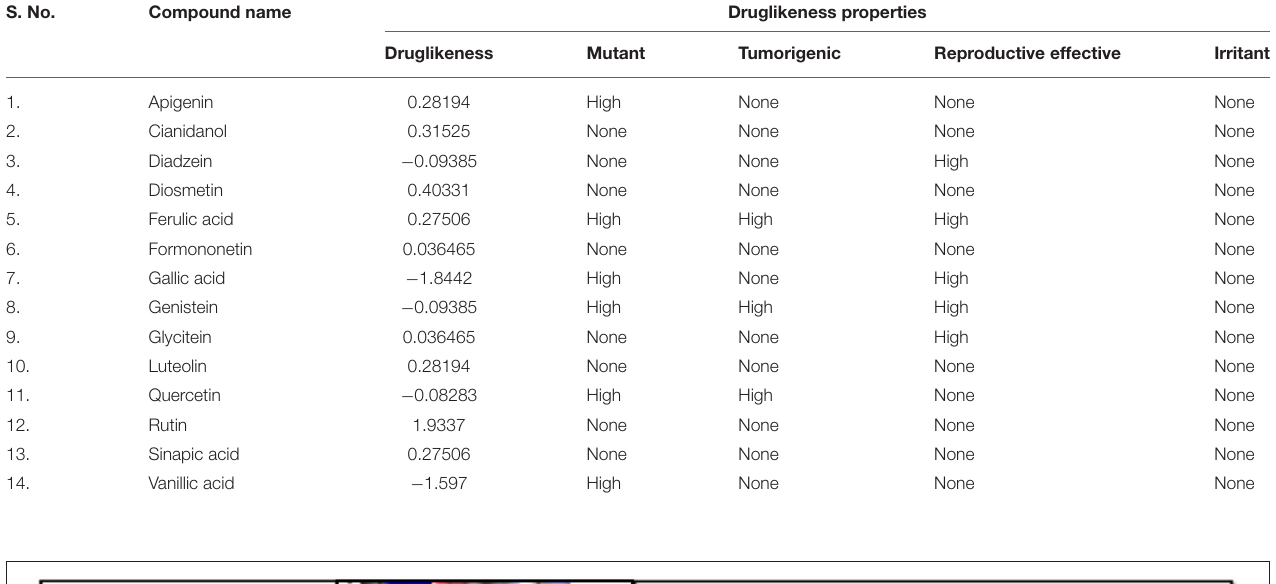
TABLE 3 | Drug-likeness and toxicity potential of palm date phytochemicals. S. No.